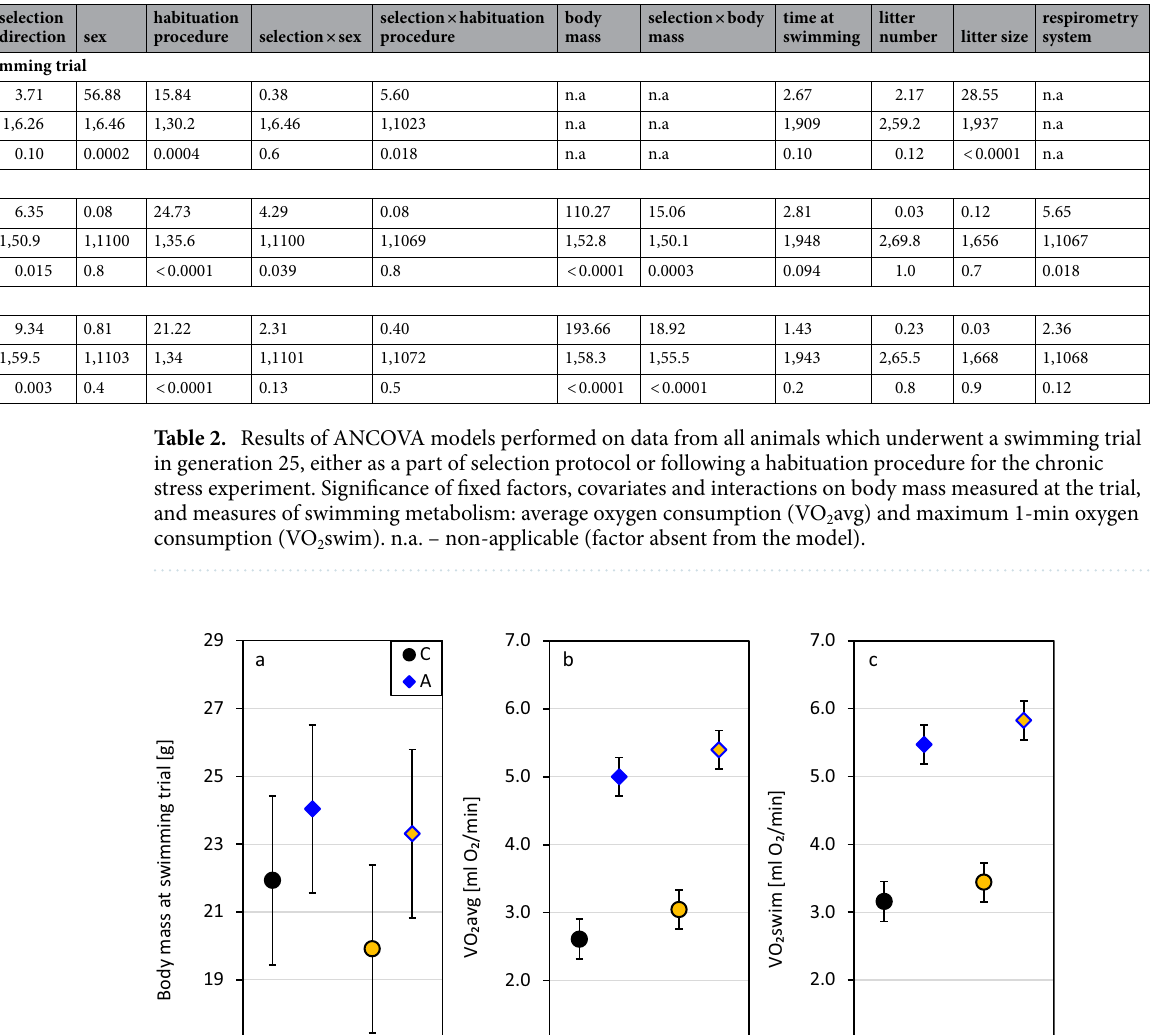
Analyses set 2: pre-treatment (initial) trait values. The analyses performed for 93 animals that com- pleted the experiment revealed that, despite random assignment, some characteristics differed between the CMS and comfort groups already before the CMS treatment was applied. Body mass (BMavg), averaged across four days preceding the treatment, ranged from 14.6 to 28.6 g among individuals (mean ± SD: C-lines: 20.65 ± 3.16 g, A-lines: 23.45 ± 2.84 g, Supplementary Table S2, Fig. 3a). Males were heavier than females ( p = 0.0012, Table 3). An imbalance was found among animals from the two selection directions assigned to two CMS treatment groups: A-line voles assigned to the CMS group tended to be heavier than those assigned to the comfort group ( p = 0.057), and the A-line voles were heavier than C-line ones in the